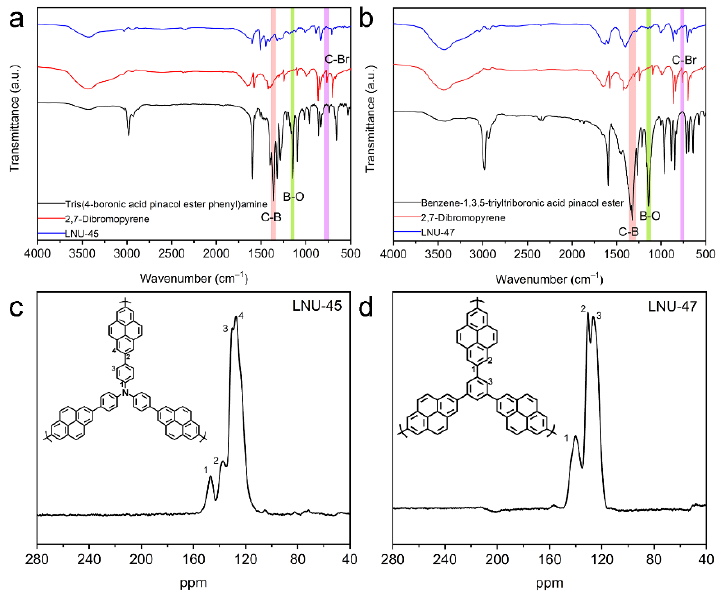
Figure 1. FT-IR spectra of LNU-45 ( a ) and LNU-47 ( b ). Solid-state 13 C-NMR spectra of LNU-45 ( c ) and LNU-47 ( d ).